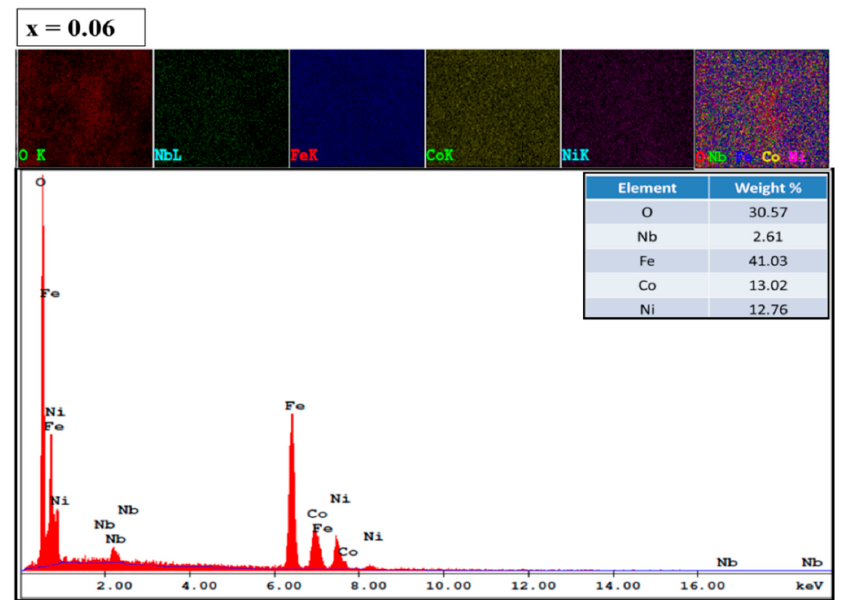
Figure 4. Energy dispersive X-ray (EDX) spectrographs and elemental mapping images of the Co 0.5 Ni 0.5 Nb x Fe 2 − x O 4 nanoparticles for x = 0.02 and 0.06.